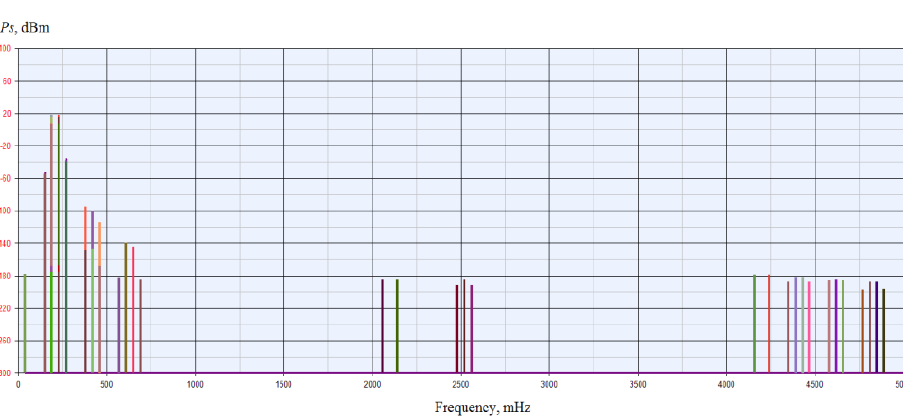
Fig. 3. A model of two receiver-tracts designed in SystemVue. Fig. 4 shows the calculated signal spectrum at the output of the shown above receiving canal.